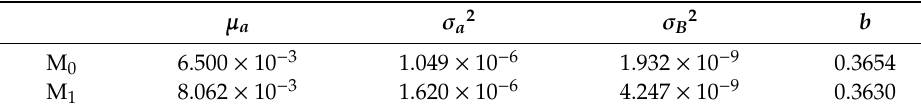
Table 9. The degradation parameters of O-type rubber sealing rings under 25 °C.